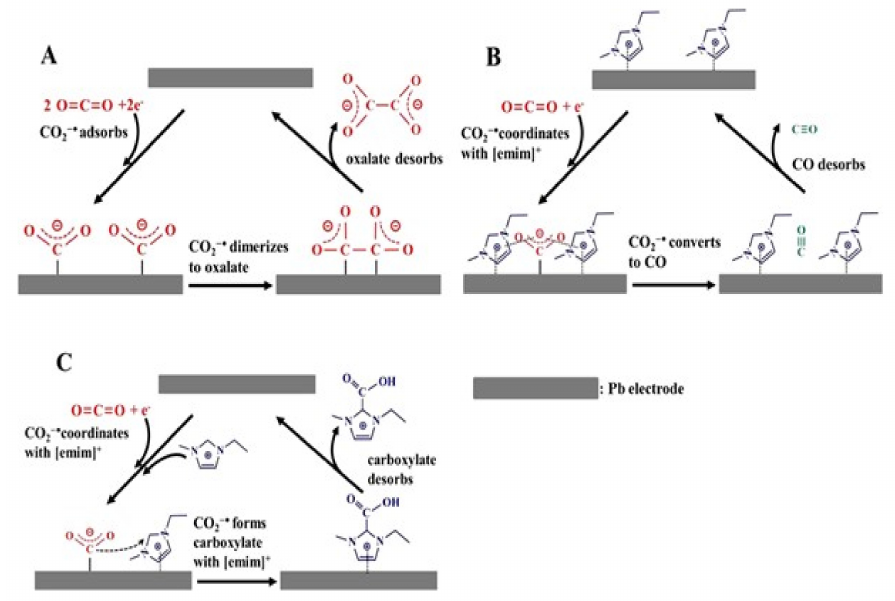
Figure 10. Reaction pathways for the electrochemical reduction of CO 2 in ( A ) the absence and ( B , C ) presence of [Emim][Tf 2 N] at a Pb electrode in acetonitrile. Reprinted with permission from [85]. Copyright 2014, American Chemical